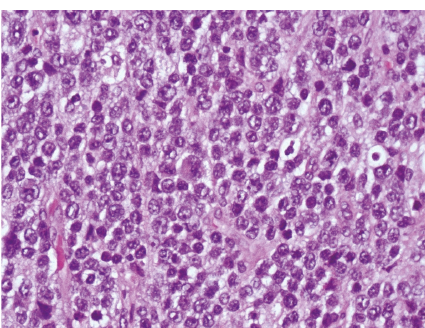
Figure 5: Medium sized atypical lymphoid cells with large vesicular nuclei and prominent nucleoli, some showing a hint of plasmacytoid differentiation.